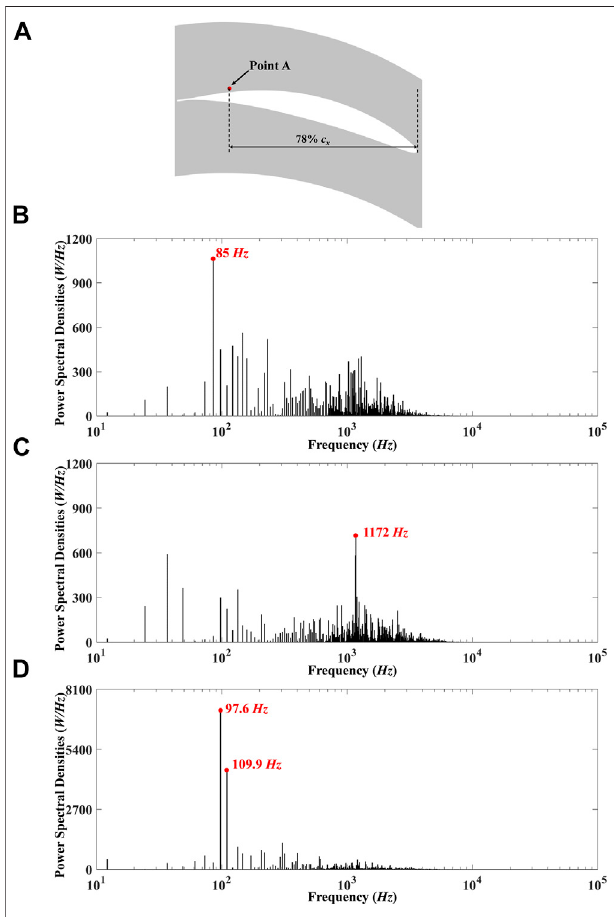
FIGURE 13 | Power spectral density distributions along with frequency. (A) Monitor point de fi nition; (B) baseline, (C) CS, (D) PS.